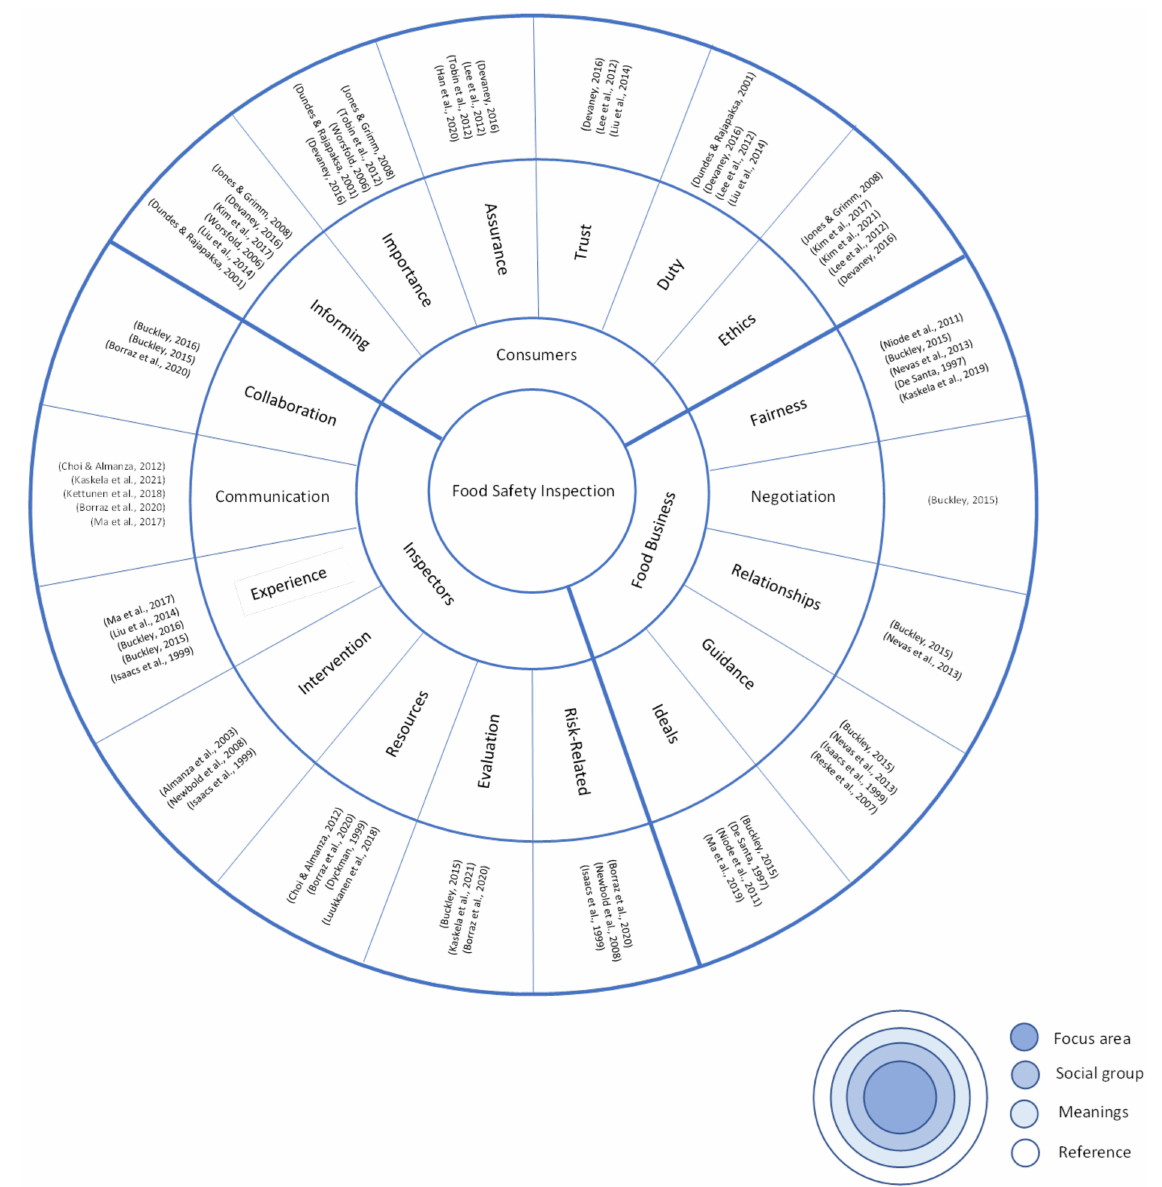
Figure 2. Meanings and